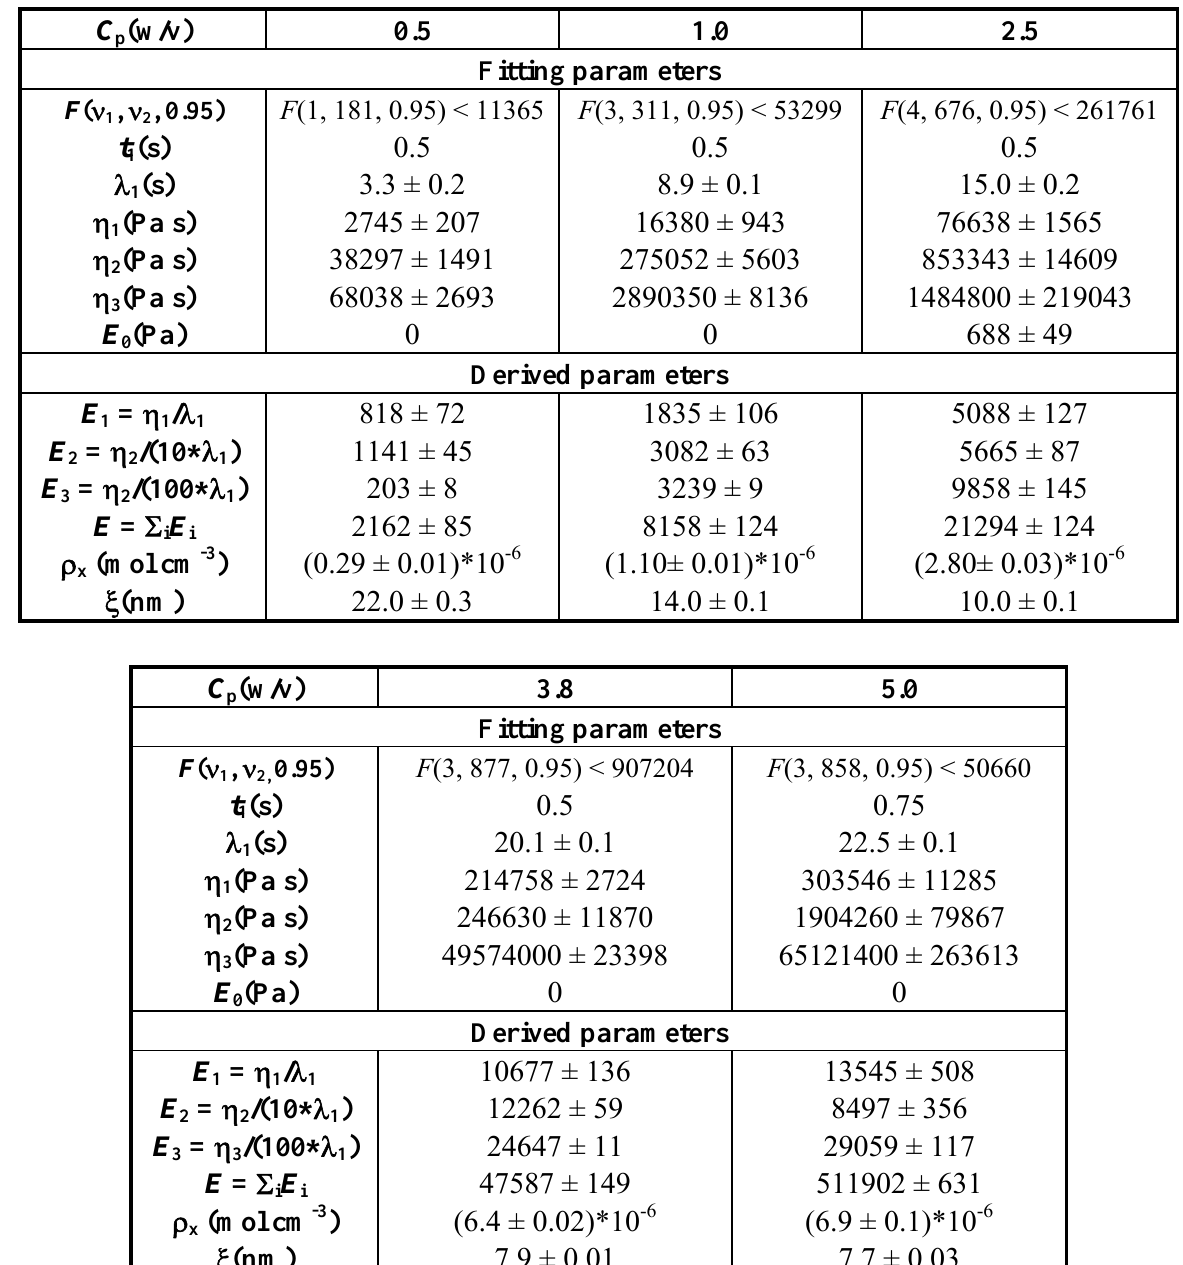
Table 1. Model best fitting parameters ( λ E , E , ρ , ξ ) referring to relaxation data. t 3 x = 10%) while F indicates “ F-statistic ” parameter. Values are reported gel deformation ( ε 0 as mean ± standard